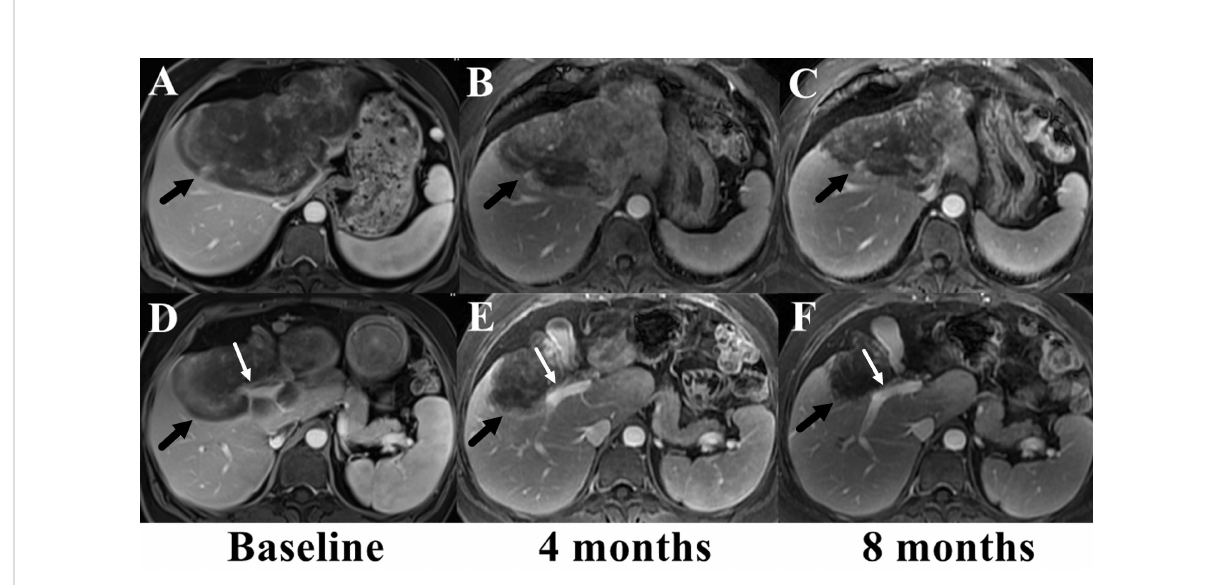
FIGURE 4 Comparison of the largest lesion on MRI before (A, D) and after the combined therapy of sirolimus and IFN-a 2b (B, C, E, F) . The tumor (marked with black arrows) gradually regressed and the involved right branch of portal vein (marked with white arrows) got released from the